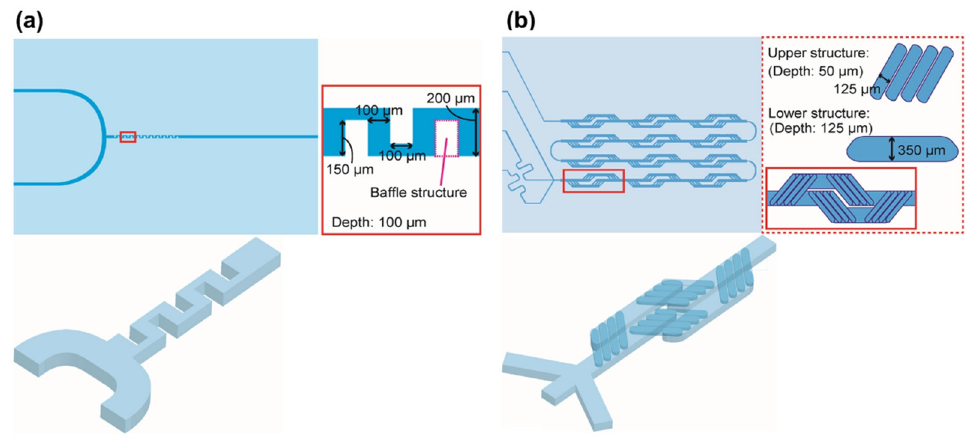
Figure 6. Schematic of (a) iLiNP (two inlets) and (b) micromixer device . Modified from [299]